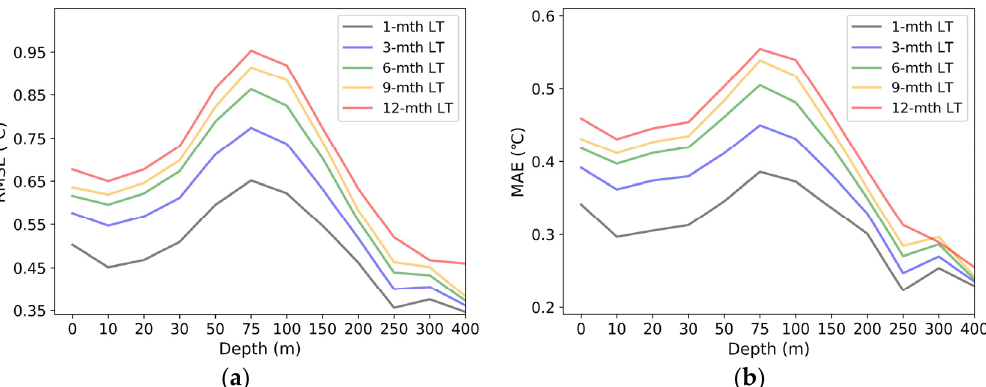
Figure 4. RMSE ( a ) and MAE ( b ) of the prediction results at different depth levels for selected lead times (LTs).